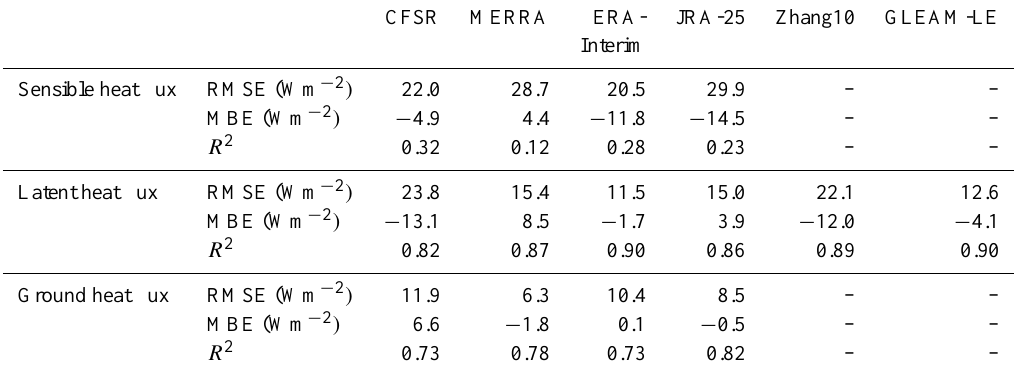
Table 3. Validation results of the surface energy budget components of reanalysis and remote-sensing data sets by comparing with in situ observation. CFSR MERRA ERA- JRA-25 Zhang10 GLEAM-LE Interim Sensible heat flux RMSE (Wm − 2 ) 22.0